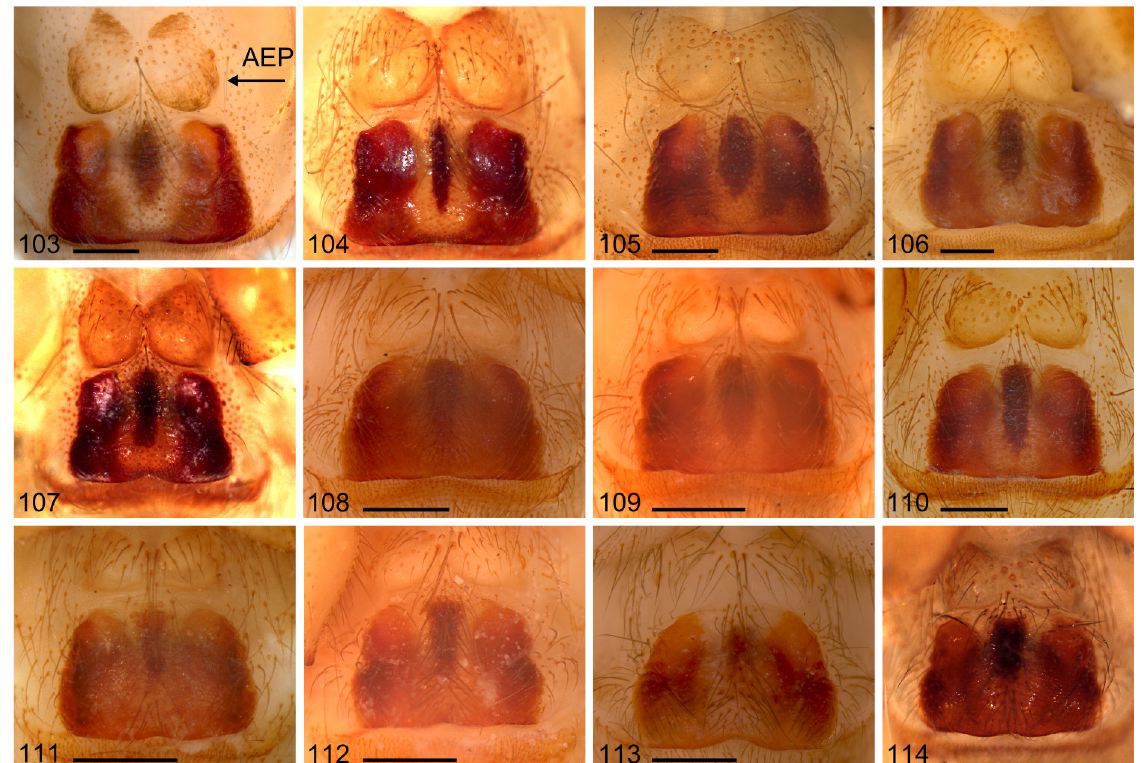
Figs 103–114. Artema doriae Thorell, 1881, intraspecific variation of epigynum. 103 . Iran, Tochal (ZFMK Ar 15233). 104 . Iran, Esfahan (FMNH). 105 . Iran, Lorestan, Ma‘amulan (MHNG). 106 .